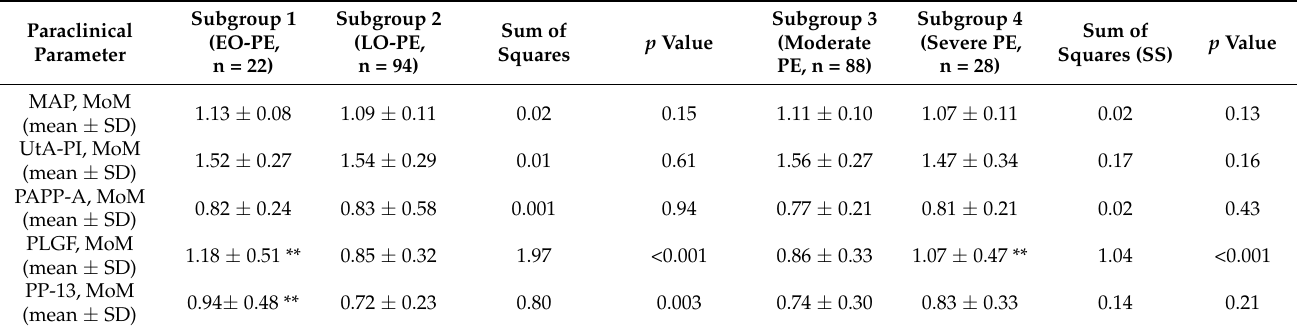
Table 3 legend: PE—preeclampsia; SD—standard deviation; MoM—multiples of median; MAP—mean arterial pressure; UtA-PI—uterine artery pulsatility index; PLGF—placental growth factor; PP-13—placental